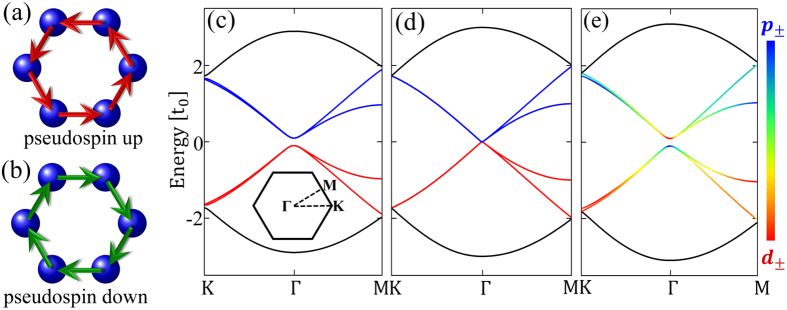
Band inversion and topological phase transition.(a,b) Current densities in the pseudospin-up channel (p+ or d+) and pseudospin-down channel (p− or d−) respectively. Band dispersions for the system given in Fig. 1: (c) t1 = 0.9t0 (Inset: Brillouin zone of the triangular lattice), (d) t1 = t0 and (e) t1 = 1.1t0. Blue and red are for |p±〉 and |d±〉 orbitals respectively, and rainbow for hybridization between them. The on-site energy is taken ε0 = 0.